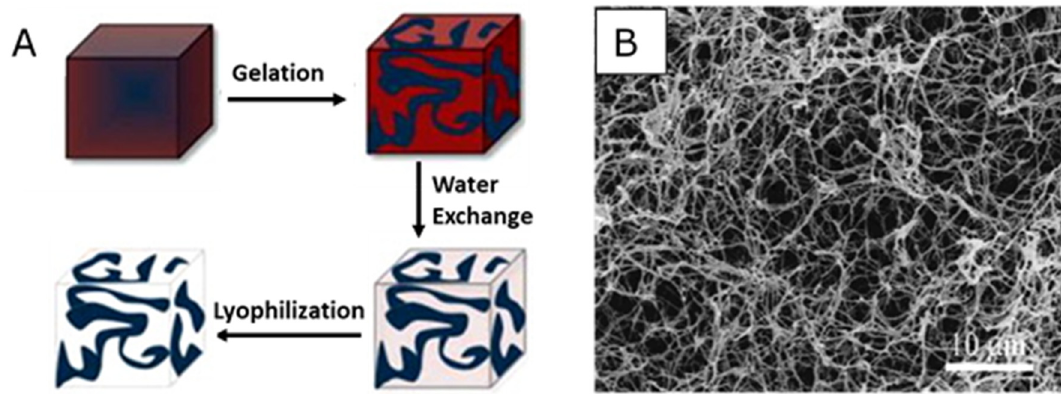
Figure 3. A schematic ( A ) of nanofiber formation by phase separation, and an SEM image ( B ) of nanofibrous structure fabricated by this technique. ( A ) was reproduced with permission from [66].